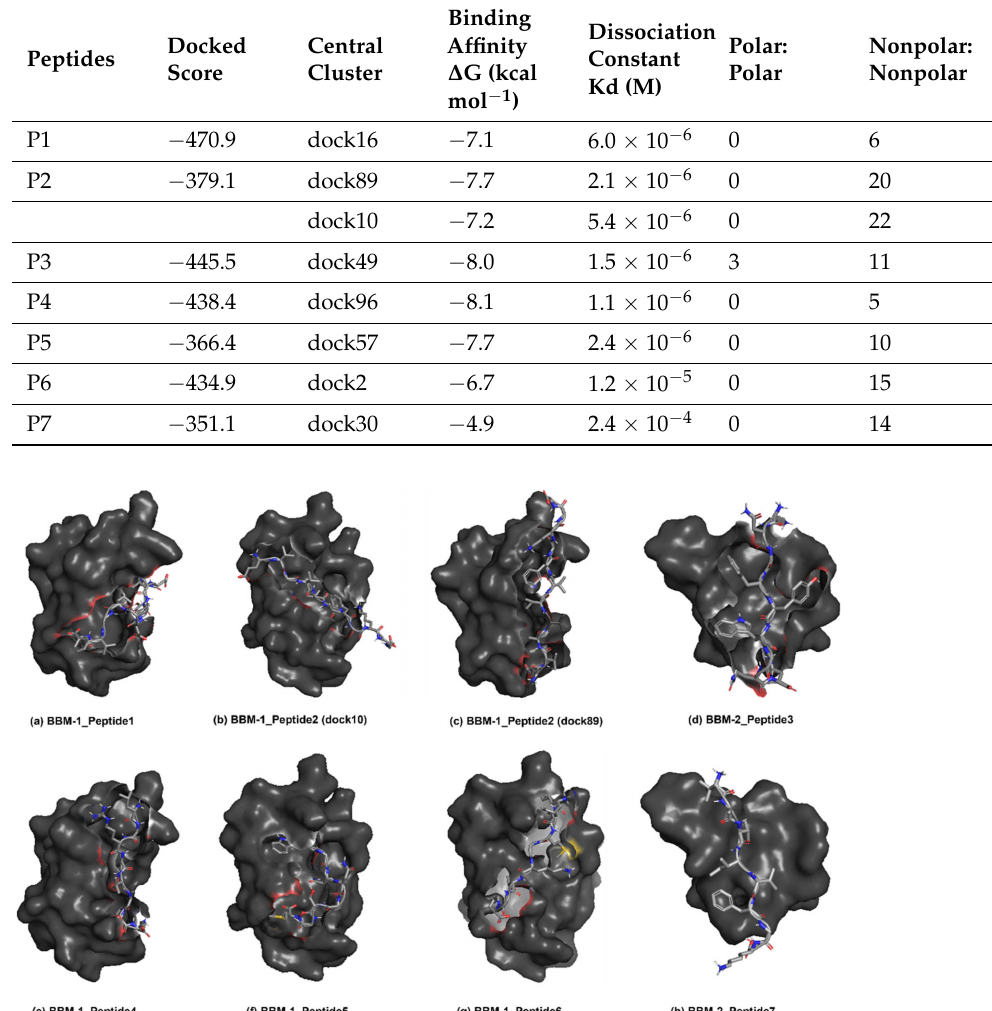
Figure 7. Best docked pose of ( a ) P1-BBM1 ( b ) P2-BBM1 (dock10) ( c ) P2-BBM1 (dock89) ( d ) P3-BBM2 ( e ) P4-BBM1 ( f ) P5-BBM1 ( g ) P6-BBM1 and ( h ) P7-BBM2